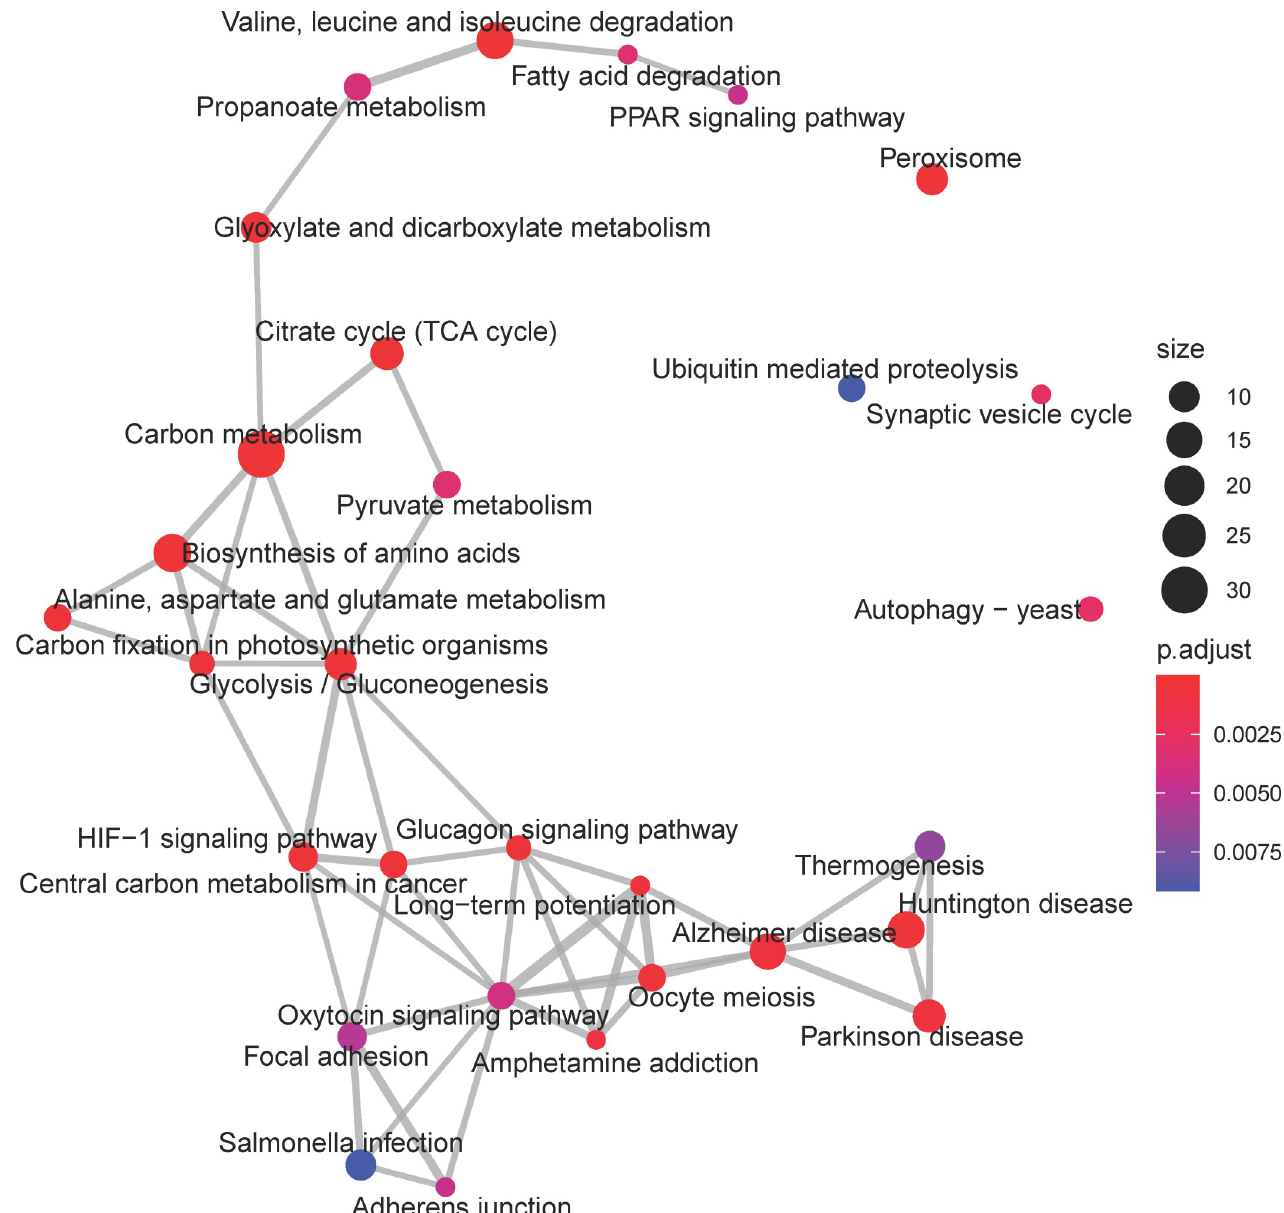
Fig 4. Enrichment map of Kyoto Encyclopedia of Genes and Genomes (KEGG) pathways for the royalblue consensus co-expression module from Aplysia californica sensory neurons. Each node represents a KEGG pathway, with node size representing the number of transcripts annotated to that pathway, and color denoting the significance of that enrichment (brighter red is most significant). KEGG pathways with overlapping transcripts sets are connected by grey lines, or edges. Edge width is determined by the number of overlapping transcripts. This module exhibits a high degree of gene set overlap between most of the enriched KEGG pathways. Metabolic pathways such as TCA cycle , Glycolysis , and fatty acid degradation are among the largest and most significantly enriched. The module eigengene trend of this module was negatively correlated with age, indicating downregulation of these pathways. 3.4.3 Orange. The three KEGG pathways significantly enriched in the orange module, which was positively correlated with age, all participate in proteostasis, whether that is proper protein folding localized to the Endoplasmic Reticulum (ER) in the case of protein processing in the endoplasmic reticulum (ko04141) and N-glycan biosynthesis (ko00510), or in protein